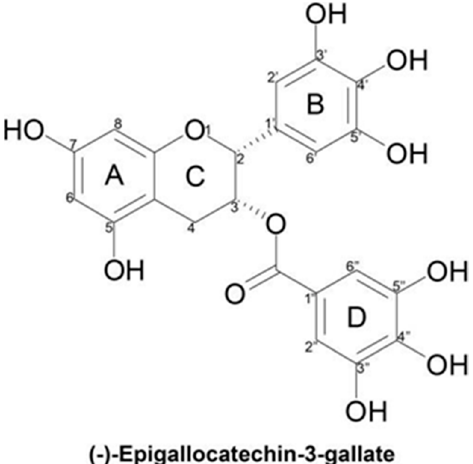
Figure 1. Chemical structure of ( − )-Epigallocatechin-3-gallate. The four rings resulting from the esterification of epigallocatechin (EGC) with gallic acid are indicated by letters (A, B, C and D) and each carbon from each ring is indicated by numbers (1–8).